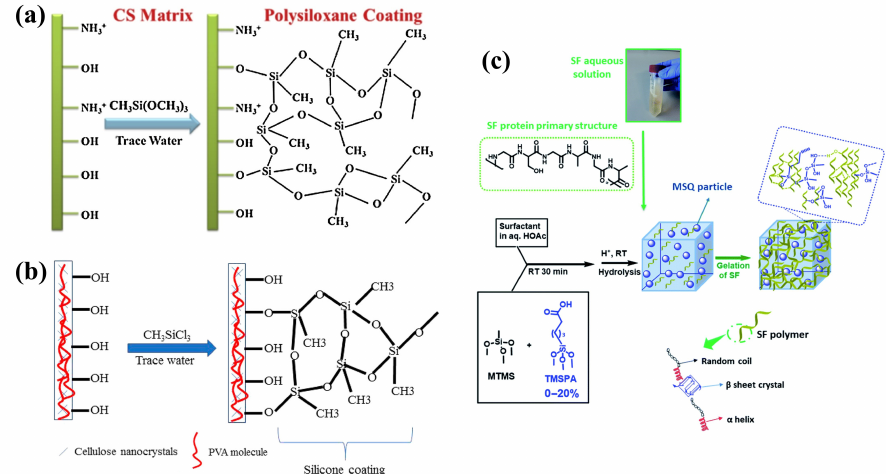
Figure 5. ( a ) Schematic illustration of the possible chemical reaction between MTMS and hydroxyl groups on the surface of chitosan. Reproduced with permission [76]. Copyright 2020, Elsevier Ltd. ( b ) Reaction scheme of MTCS with hydroxyl groups on the surface of the aerogel. Reproduced with permission [87]. Copyright 2019, American Chemical Society. ( c ) Synthesis of PMSQ-SF hybrid aerogels by using silicon-based coupling agent. Reproduced with permission [97]. Copyright 2018, Royal Society of